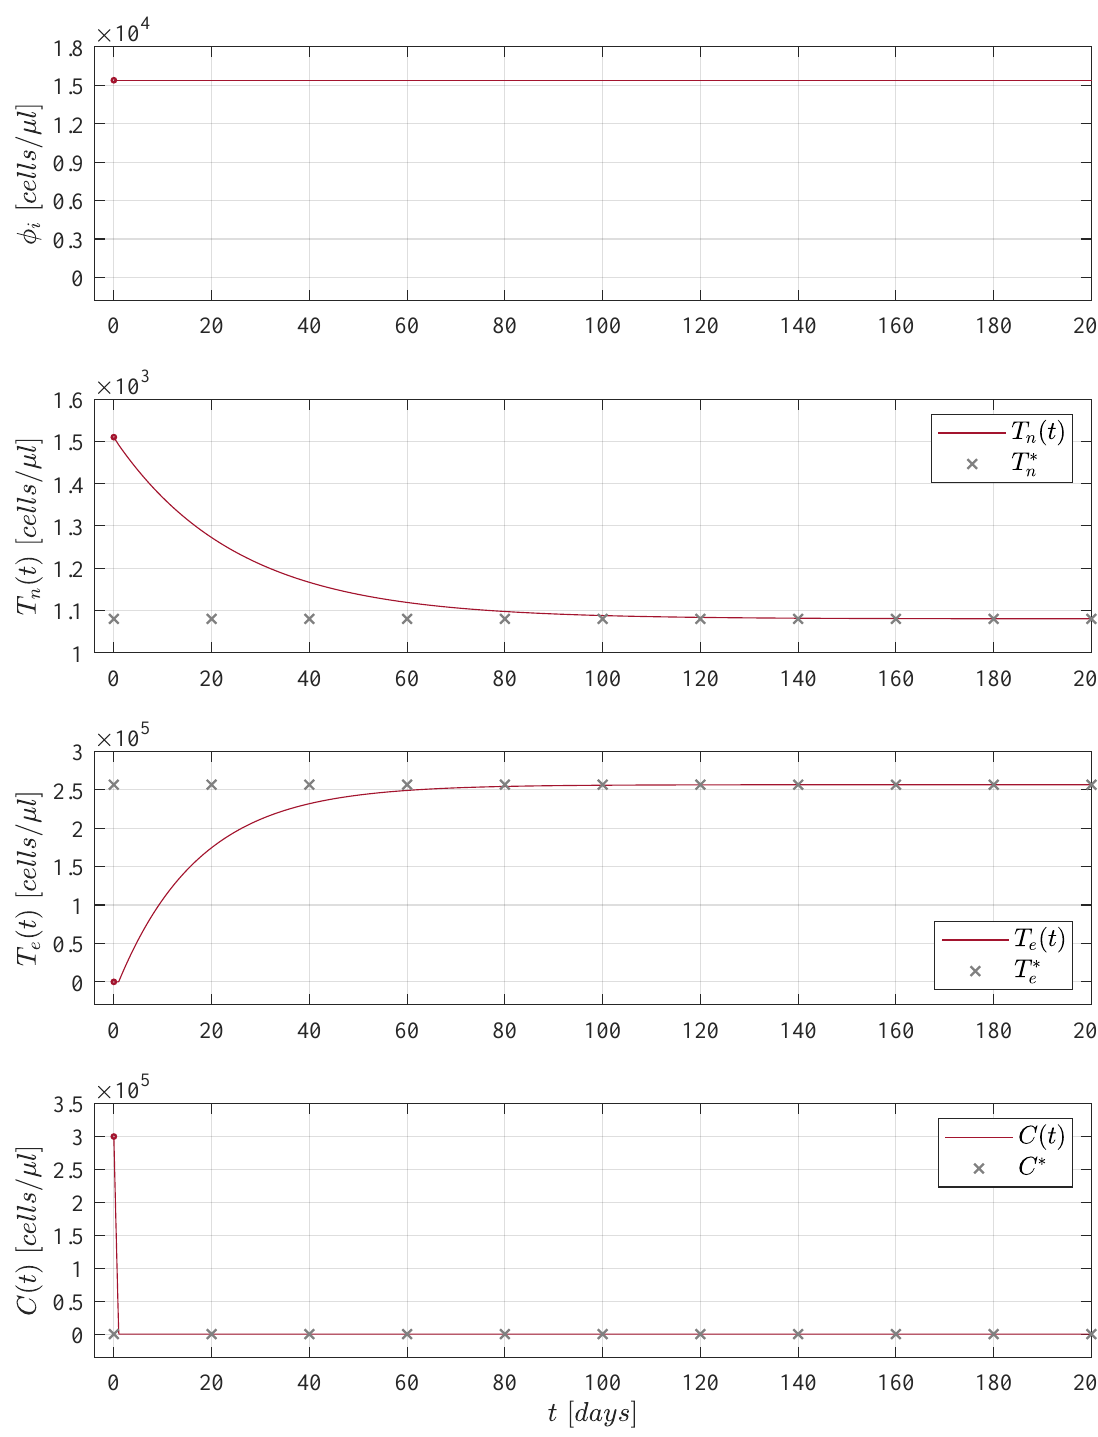
Figure 1. When the cellular immunotherapy treatment parameter fulfills condition (7), i.e., φ i = 1.01 × φ inf , all solu- tions for the CML-Immunotherapy system (1)–(3) go to the tumour-free equilibrium point (8) given by ( T ∗ n , T ∗ e , C ∗ ) = ( s n / d n , φ ) . For this particular case, we set the initial tumour density as C ( 0 ) = C max = 3 × 10 5 cells/ µ L, as we i / d e ,0 consider the concentration of leukemia cancer cells at the maximum carrying capacity. Different initial conditions will